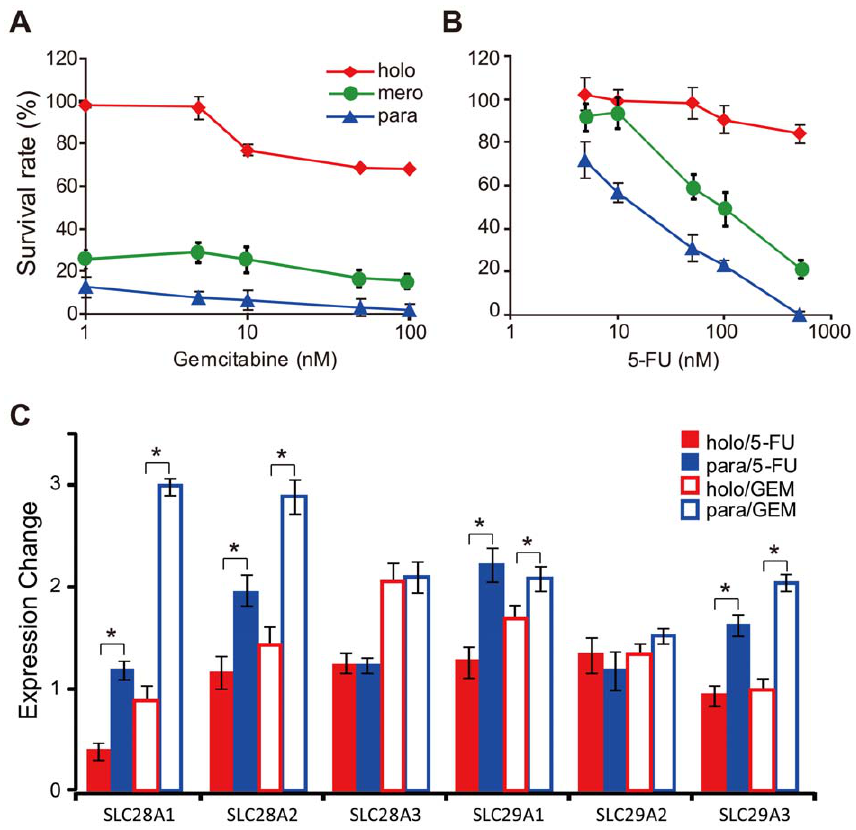
Figure 6. Differences in chemoresistance among holoclones, meroclones and paraclones. Cells isolated from holoclones, meroclones and paraclones were treated with chemotherapeutic drugs of increasing concentration: 1, 5, 10, 50, 100 nM of gemcitabine (A) or 5, 10, 50, 100, 500 nM of 5-FU (B). For each concentration value, three wells were set as repeat in a single experiment and three times of representative experiments were performed. The expression changes of chemo-drug intake transporters were quantified in holoclones and paraclones respectively after treated with 50 nM chemo-drug for 12 hours. (C) (*, p , 0.05).